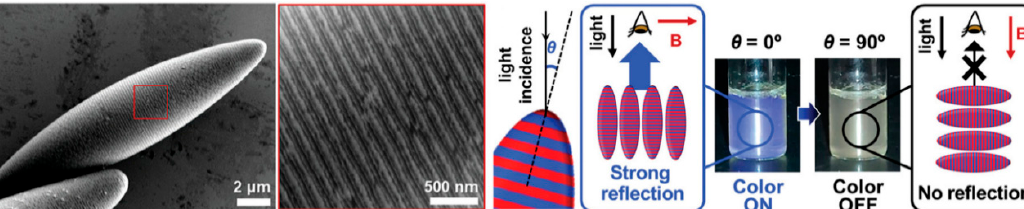
Figure 8. Magnetic-responsive color-switchable photonic ellipsoidal particles created from dendronized brush block copolymers (reprinted with permission from [91], Copyright 2020, American Chemical Society).